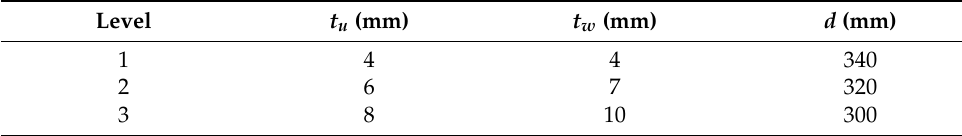
Table 1. Factors and levels of orthogonal experiment.